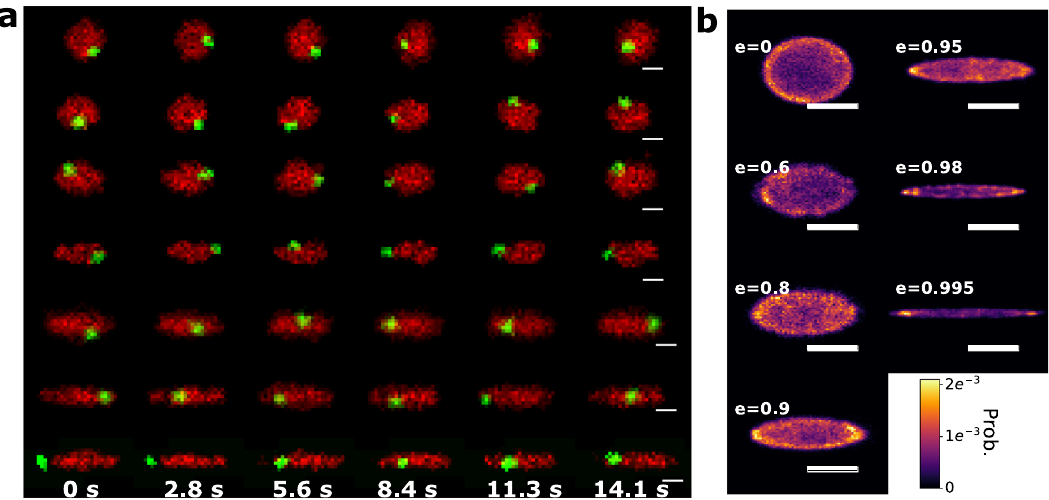
Fig. 4 Experimental results and equilibrium analysis for a cavity con fi ned plasmid in presence of T 4 -DNA. a Montage of fl uorescence images of cavity con fi ned T 4 -DNA and plasmid DNA for cavities of varying eccentricity. The red color indicates T 4 -DNA while the green indicates plasmid DNA. The scale bars are 2 μ m. b Histogram of plasmid center-position while con fi ned with T 4 -DNA, yielding an estimate of the probability density function for plasmid position in the cavity. The scale bars from top to bottom correspond to 1 μ m, 1 μ m, 1 μ m, 1.2 μ m, 1.2 μ m, 1.6 μ m and 1.6 μ